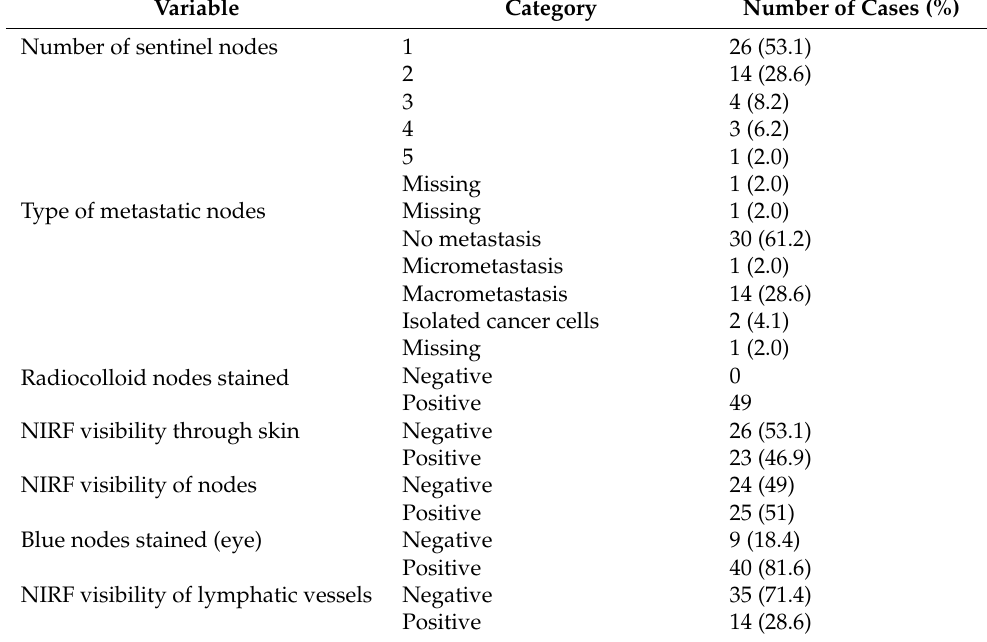
Table 2. Analysis of sentinel lymph node